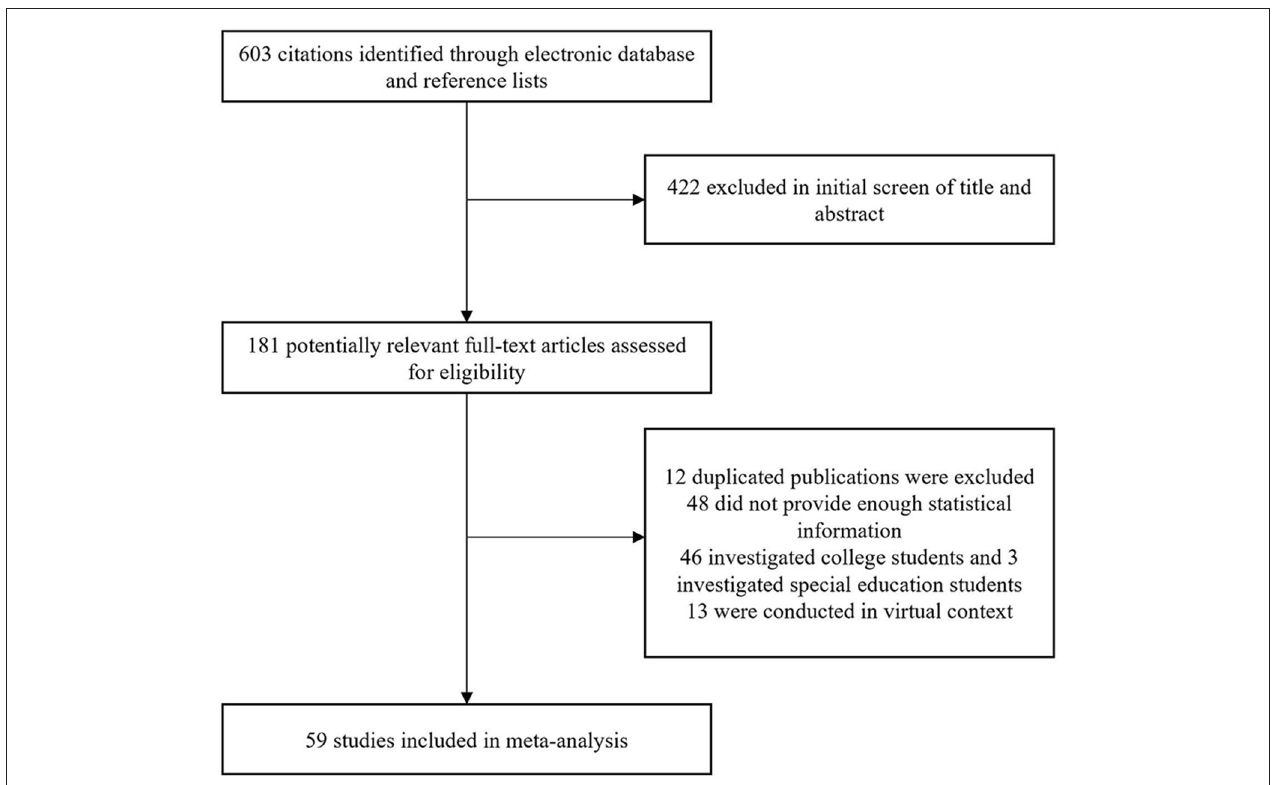
FIGURE 1 | Flow diagram of papers included in the present